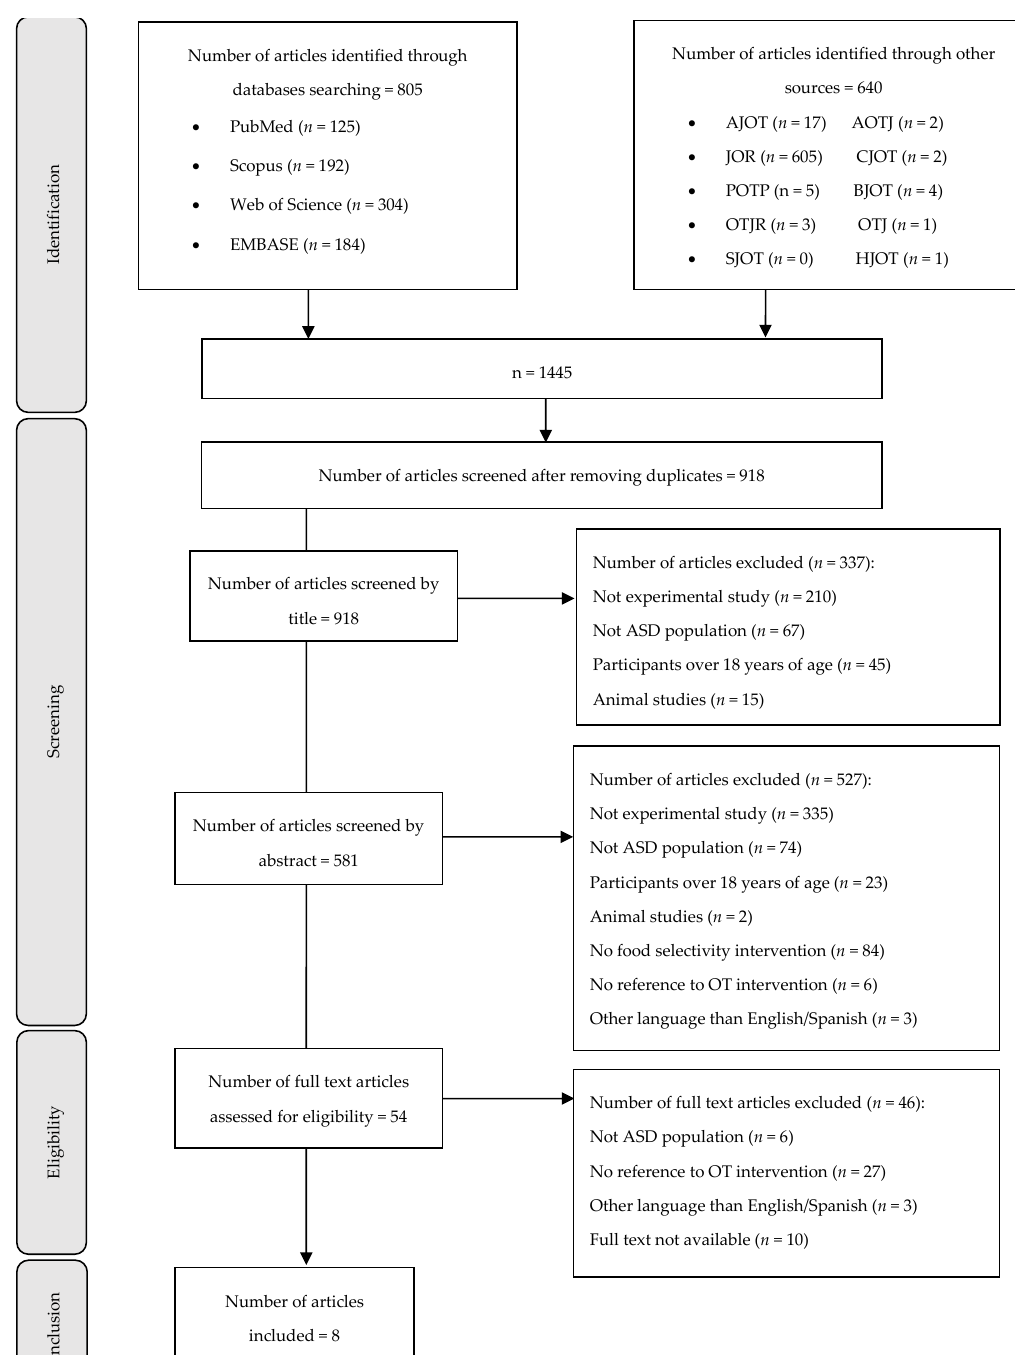
Figure 1. Flowchart of the study selection process: AJOT, American Journal of Occupational Therapy ; AOTJ, Australian Occu- pational Therapy Journal ; BJOT, British Journal of Occupational Therapy ; CJOT, Canadian Journal of Occupational Therapy ; JOR,